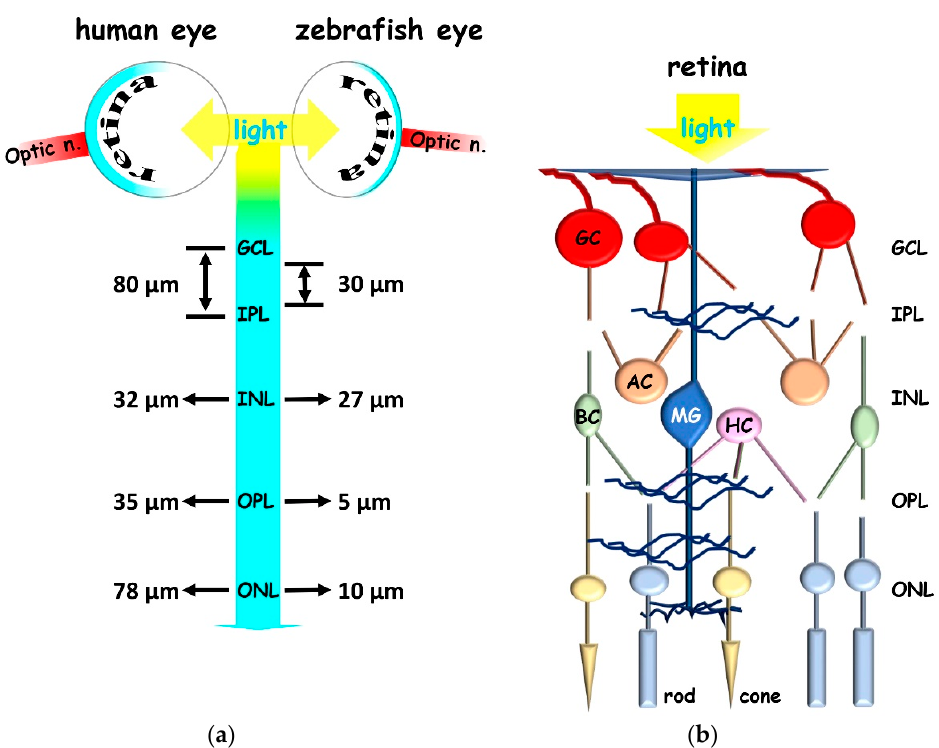
Figure 1. Schematic representation of human and zebrafish retina. ( a ) Retinal layers thickness. ( b ) Retinal layers and the main neuronal types. GCL (ganglion cellular layer); IPL (inner plexiform layer); INL (inner nuclear layer); OPL (outer plexiform layer); ONL (outer nuclear layer); GC (ganglion cell; red); AC (amacrine cell; orange); BC (bipolar cell; green); MG (Müller glia; blue); HC (horizontal cell; pink); rod (light blue), cone (yellow), optic n. (optic nerve).